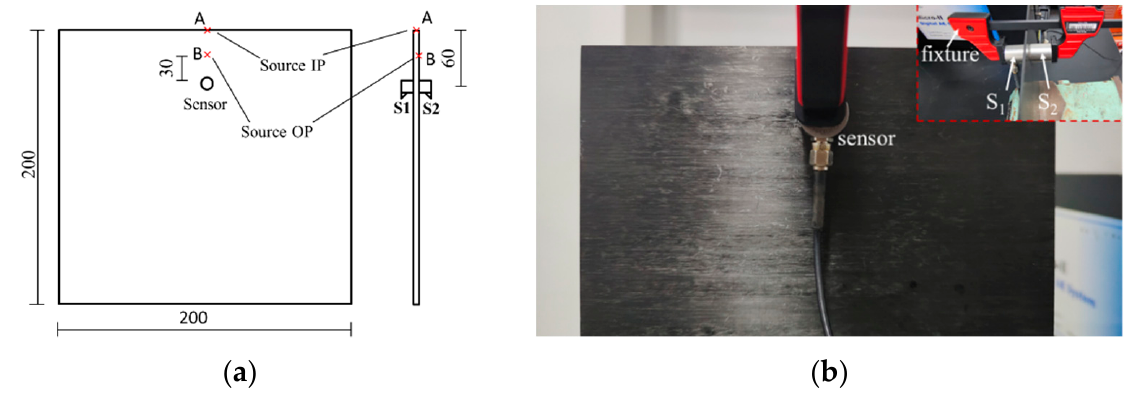
Table 1. Parameter setting of the AE monitoring system.